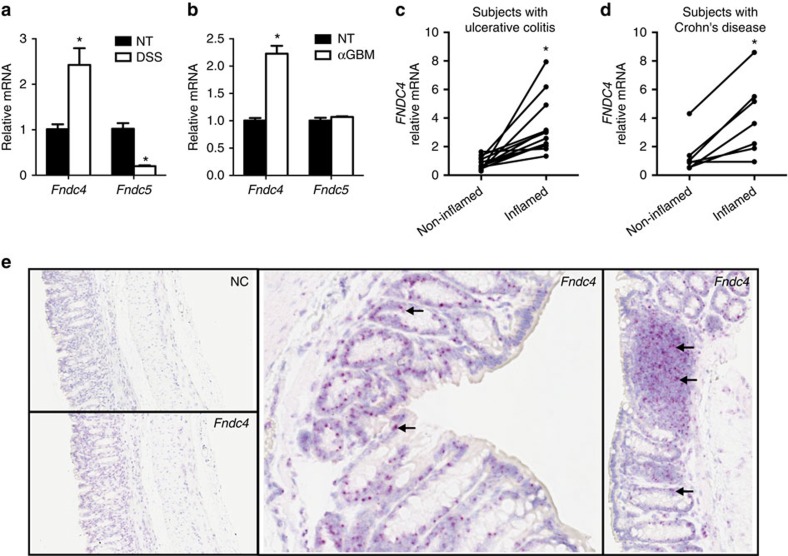
Fndc4 gene expression is upregulated in inflammatory conditions.(a) Fndc4 gene expression in the murine colon on induction of DSS-mediated colitis. DSS was administered via the drinking water, mice were sacrificed 7 days later, N=10 mice per group. NT, non-treated. Mean±s.e.m., *P<0.05 (Student's T-test). This experiment was performed three times with similar results. (b) Fndc4 gene expression in the kidney on induction of glomerulonephritis. Mice were injected with antiserum directed against the glomerular basement membrane (αGBM) and sacrificed 5 days post injection. NT, non-treated. N=5 mice per group. Mean±s.e.m., *P<0.05 (Student's T-test). This experiment was repeated once with similar results. (c–d) Human IBD cohort. FNDC4 gene expression in intestinal biopsies from inflamed versus non-inflamed regions of the same patients with ulcerative colitis (UC) (N=12) (c) or Crohn's disease (CD) (N=7) (d). *P<0.05, paired T-tests. (e) RNA in situ hybridization. Distal colon from DSS-treated mice. Fndc4 versus negative control (NC) probe. Arrows point at examples of positive signals (red).